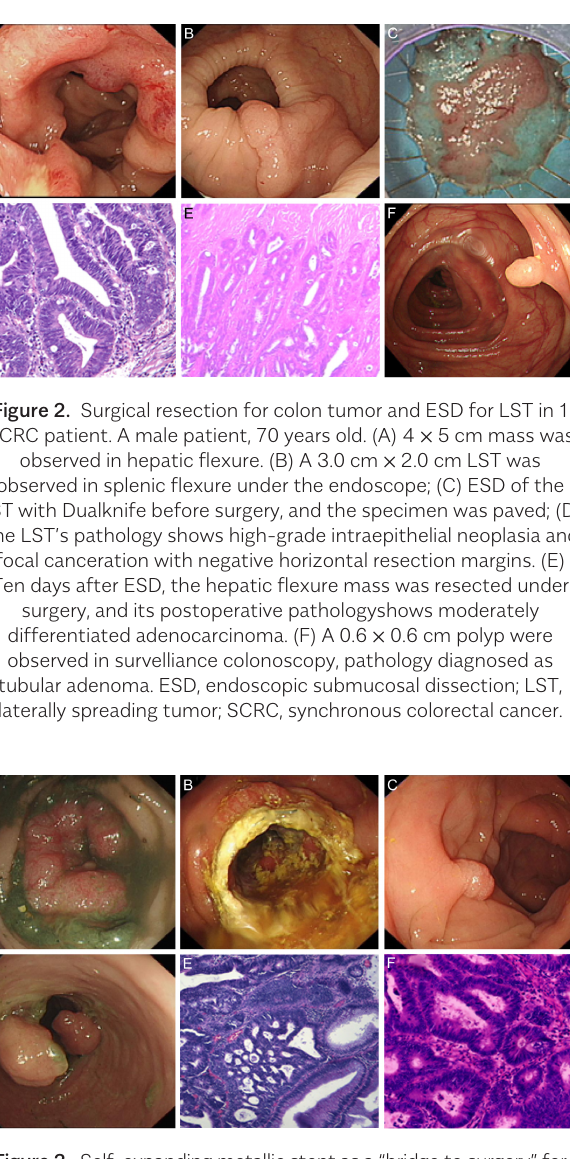
Figure 3. Self-expanding metallic stent as a “bridge to surgery” for obstructive colon cancer and EMR for earlier-stage cancer in one SCRC patient. A male patient, 72 years old. (A) Colonoscopy reveals a bulky tumor at the splenic flexure, a standard colonoscope or gastroscope cannot through. (B) A SEMS was placed through the stenosis. (C) One week later, colonoscope pass through the tunnel without resistance and reach to the cecum. A 0.8 × 0.8 cm polyp was observed in ascending colon and resected by EMR. (D) Another two 1.5 × 1.5 cm polyp were observed in sigmoid colon (at 15 cm above the anus) and resected by EMR too. (E) The sigmoid polyp’ pathology shows high-grade intraepithelial neoplasia and focal canceration with negative horizontal resection margins. (F) The bulky tumor was operated removed 1 week after EMR. Its postoperative pathology shows highly differentiated adenocarcinoma. SEMS, self-expanding metallic stent; EMR, endoscopic mucosal resection; SCRC, synchronous colorectal